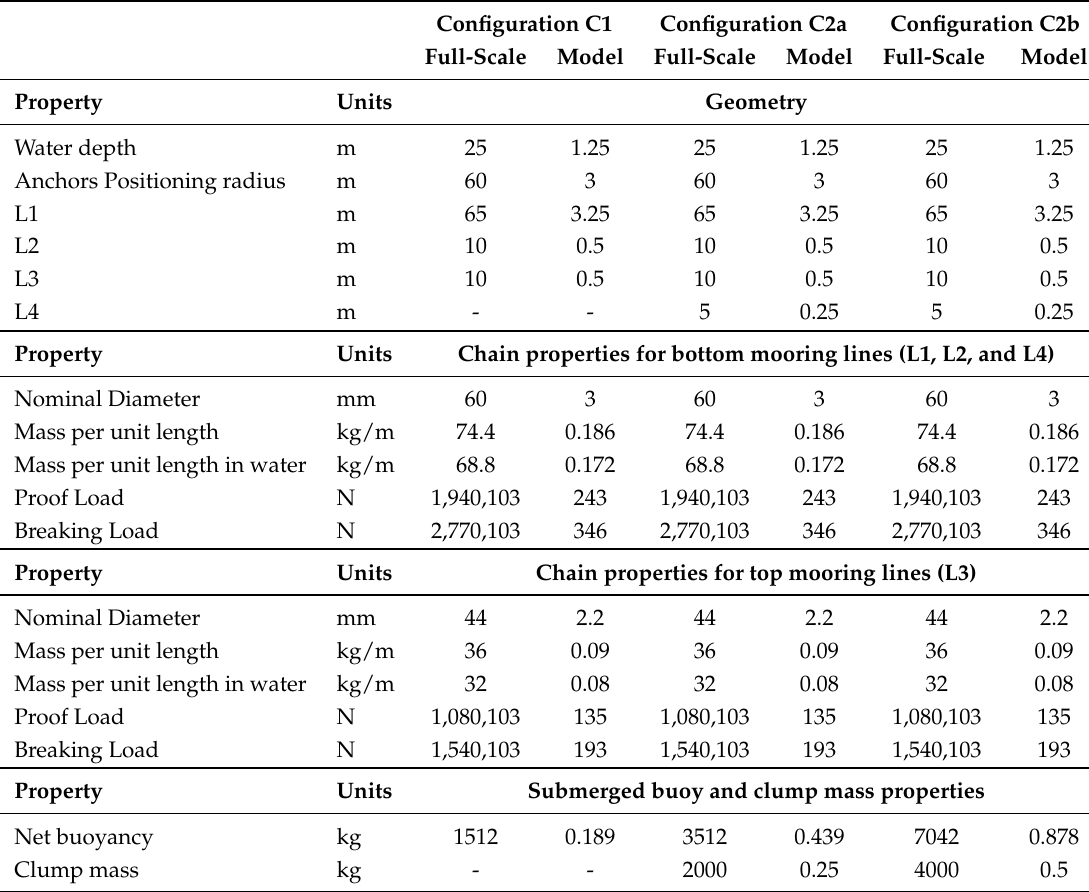
Table 3. ISWEC mooring system properties, Configuration C1 and C2.